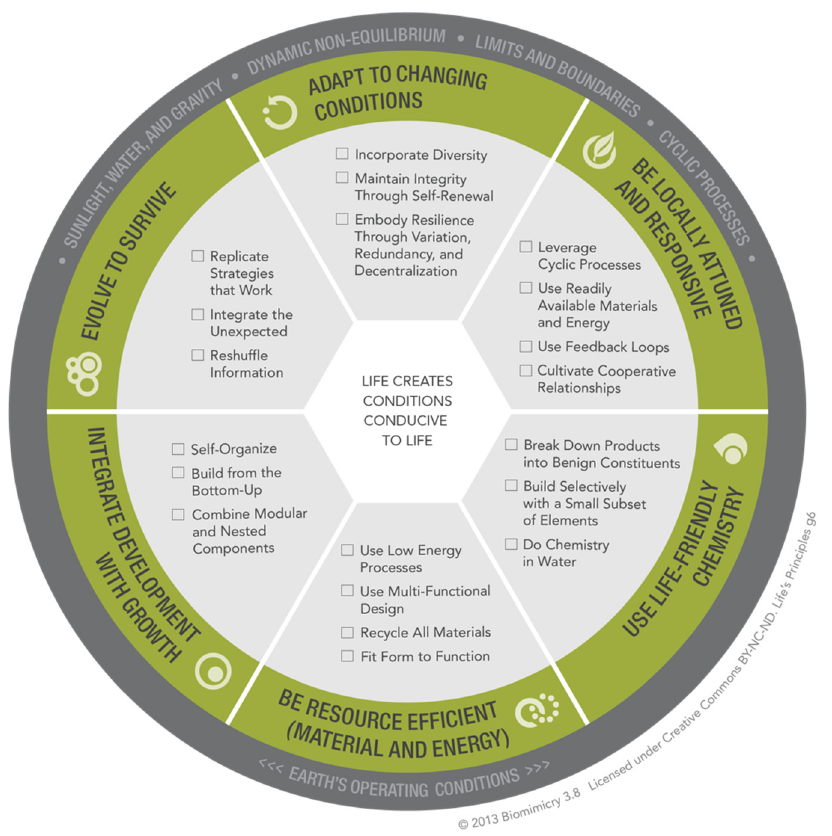
Figure 1. Six main biomimicry Life’s Principles and their sub-principles. ©2015 Biomimicry 3.8.